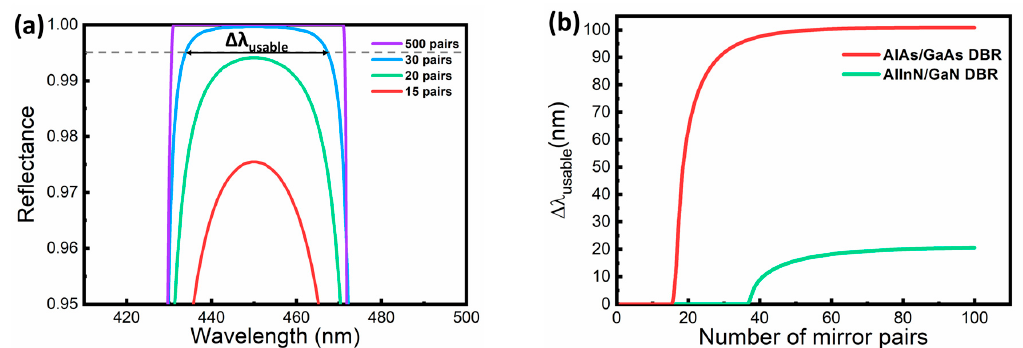
Figure 2. ( a ) A close-up of the reflectance spectrums near the peak as the number of pair increases. Here a threshold of R > 99.5% is used above which the portion of the reflectance spectrum is defined as “usable” with a width of ∆ λ usable . ( b ) Plot of ∆ λ usable vs the number of DBR pairs for two lattice matched material systems, AlAs / GaAs and AlInN / GaN. The large di ff erence of ∆ λ usable is due to mainly a 2 × di ff erence in wavelength and almost 3 × di ff erence in ∆